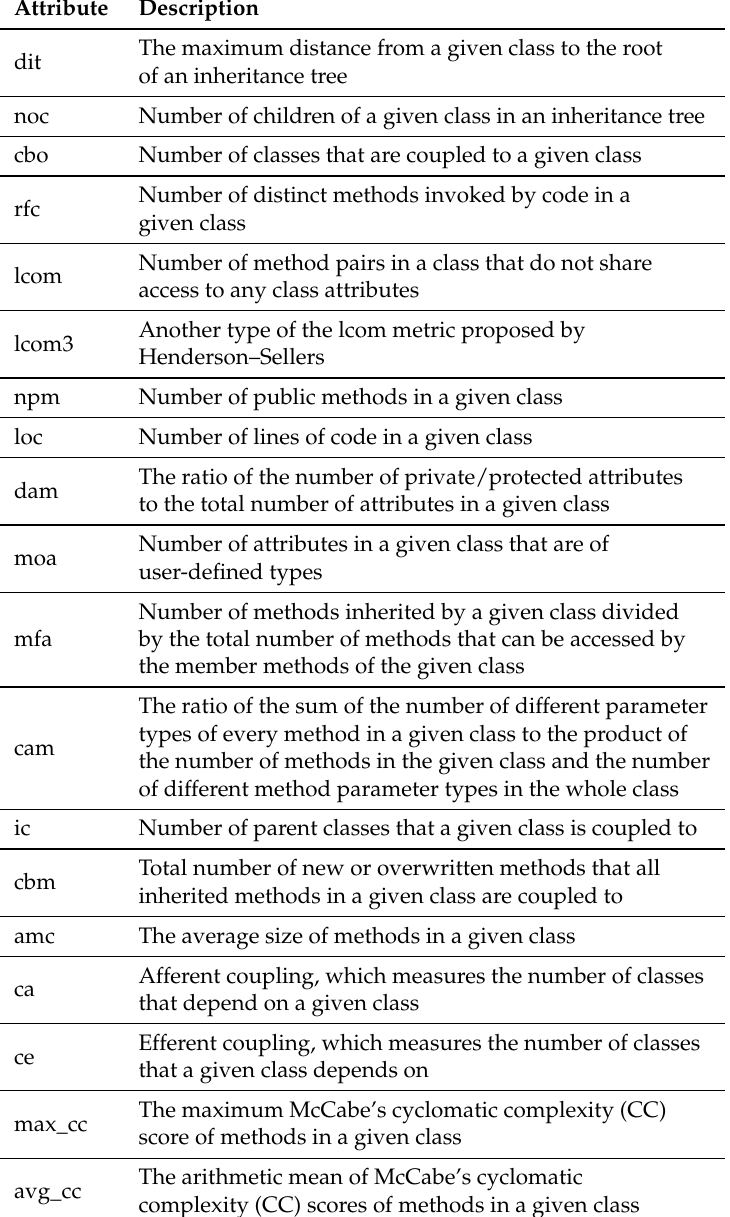
Table 3. List of 20 static metrics of PROMISE. The descriptions were given in